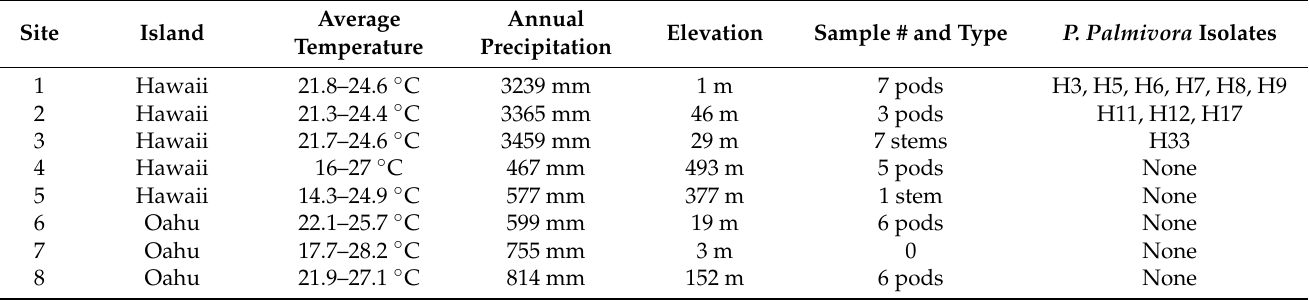
Table 1. Sites where diseased cacao material was sampled and processed for Phytophthora spp. recovery. P. palmivora was obtained from three sites on Hawaii Island but was not detected on